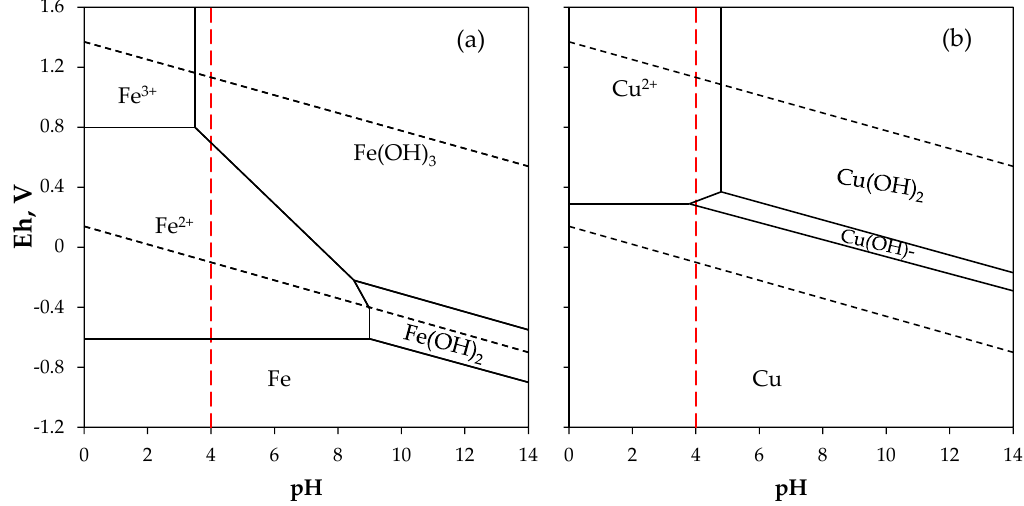
Figure 3. Pourbaix diagram for ( a ) iron and ( b ) copper at 25 °C. Vertical lines at pH 4 denotes the precipitating condition used in the treatment of leached tailing (PLS) solution.